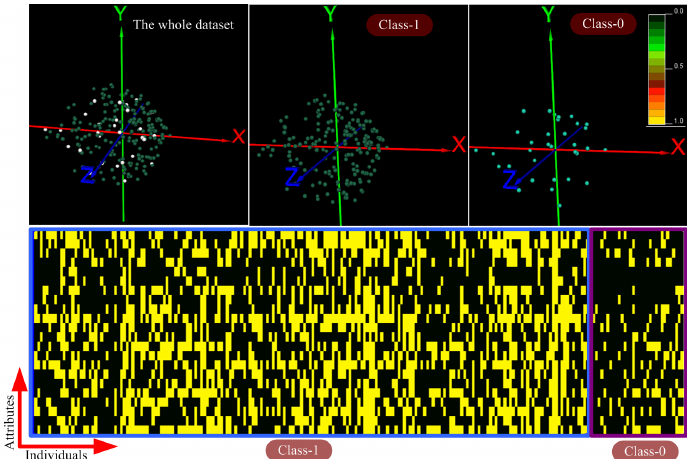
Figure 1. DS1 dataset (Heart Dataset). A 3D-scatterplot is shown at the top of the figure where each point represents a column (an individual) of the dataset showed as a heatmap at the bottom. The dimension of the dataset was reduced to three components by using principal component analysis. In addition, points belonging to each class are shown in different colors. The heatmap corresponding to the same dataset is shown at the bottom of the figure. Each class of the dataset is framed in a box. The color bar shown at the top represents the color scale used in the heatmap.